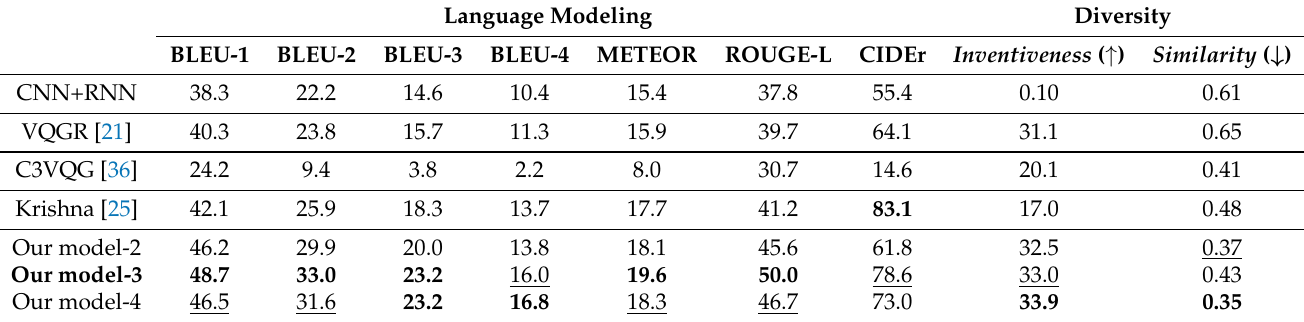
Table 2. Comparison of our model with other previous state-of-the-art models in terms of language modeling and diversity. These language modeling metrics represent the accuracy of the word level, and a high score indicates the model’s good performance. For the diversity metrics, high Inventiveness and low Similarity represent better performance. Our model variants, i.e., model-2, -3, and -4, represent models with 2, 3, and 4 latent spaces, respectively. The bolded numbers in the table are the best results, and the underlined numbers are the second best results.